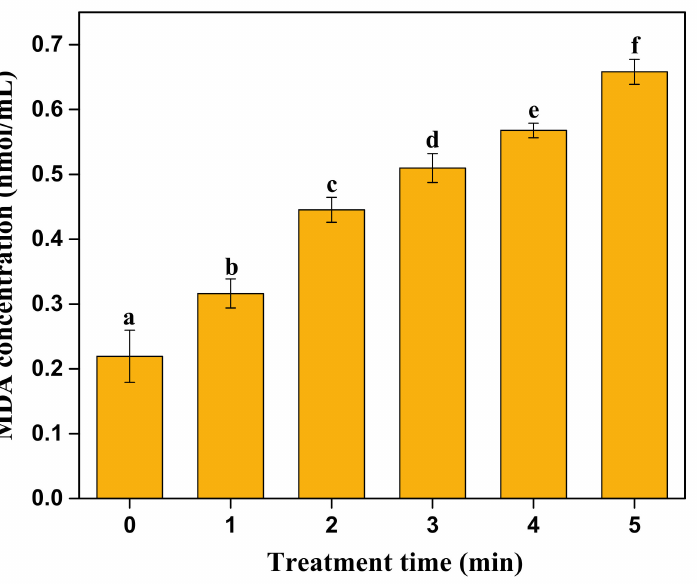
Figure 6. MDA changes of S. typhimurium suspension after cold plasma treatments. Different letters indicate the significant difference ( p <